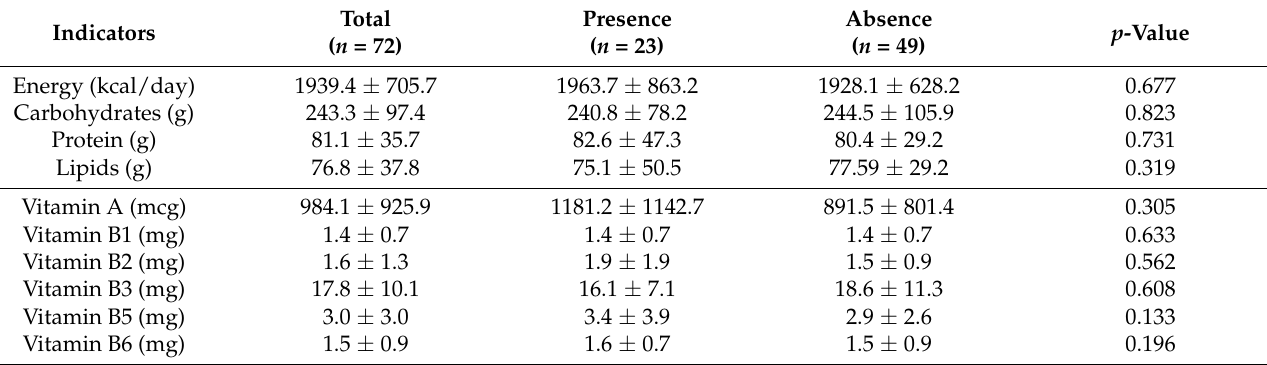
Table A4. Dietary characteristics regarding